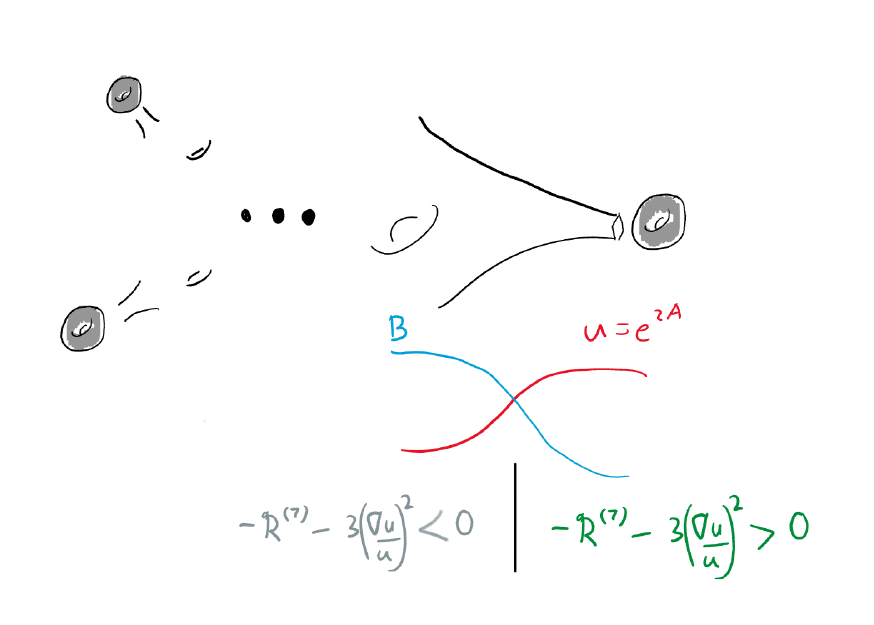
Figure 2: Schematic of the spatial structure of our compactification. Casimir energy is concentrated in regions with small circles, e.g. filled [ 19 ] cusps as pictured here, or other types of systoles [ 20 ] ( the systole of a manifold being its shortest closed noncontractible geodesic). The constraint equation (3.7) is related to a Schrödinger problem. The solution contains gradients of the analogue wavefunction, the warp factor u = e 2 A , as discussed e.g. in §5.1.1-5.1.2, and the conformal factor B also varies internally, enabling a small value of the net curvature term in the effective po- tential. We schematically sketch the hyperbolic space dressed with the varying warp and conformal factors; explicit solutions illustrating the back reacted filled cusp ge- ometry appear in section 5.3. The direction of variation of the deformation B away from the hyperbolic space arises because the negative curvature pushes outward on the volume, whereas the Casimir energy contributes a force in the opposite